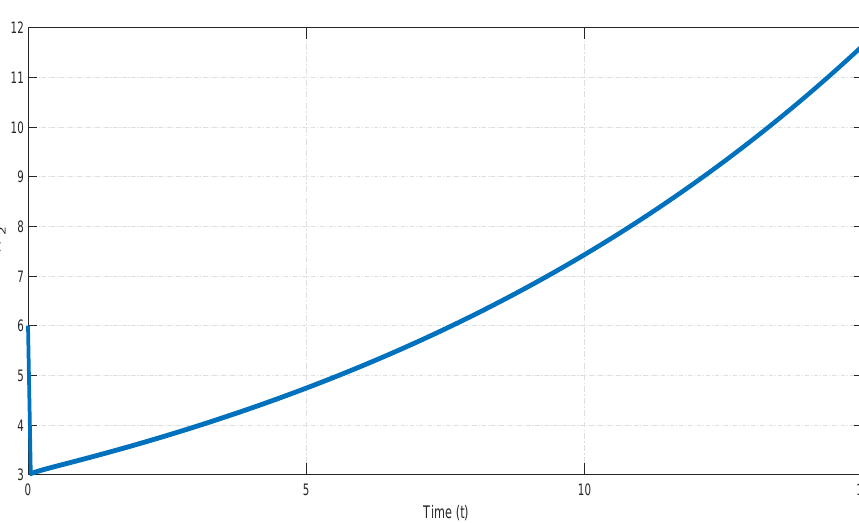
Figure 4. The value of x T ( t ) l 2 of the first subsystem in Example 2.